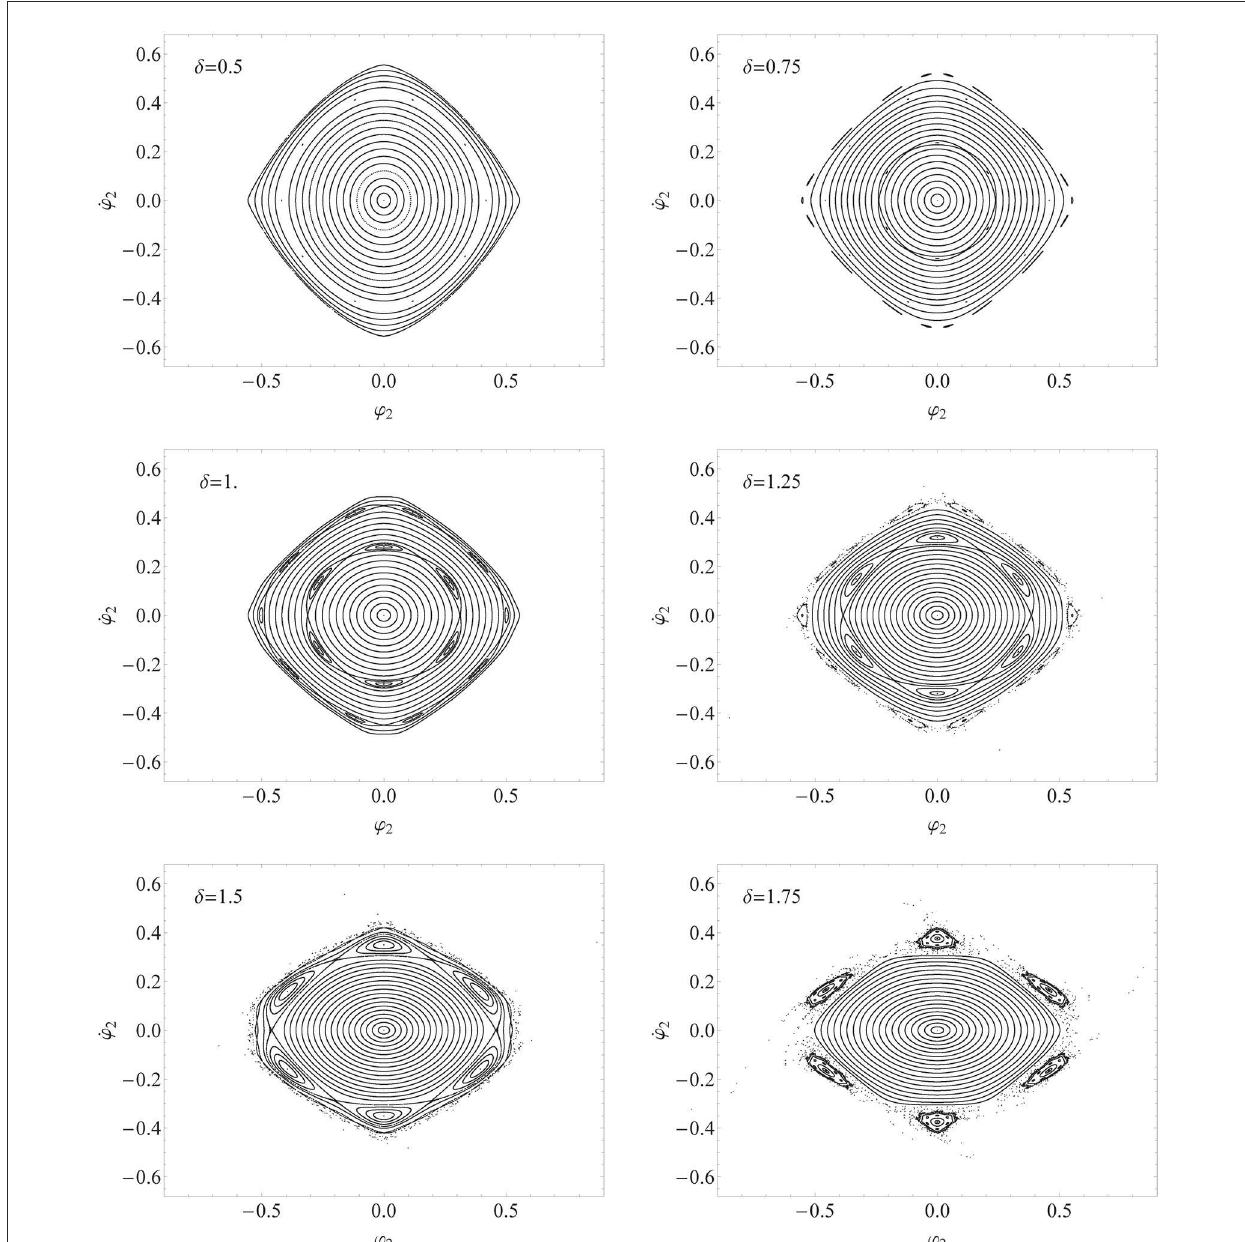
FIGURE7 Poincaré maps in the displacement-velocity phase plane for several sets of initial conditions, see Equation (40), and load amplitude δ from half of the value of the first static critical load, ( δ = 0.5), to δ = 1.75, at fixed load frequency ( (cid:127) = 4.0).